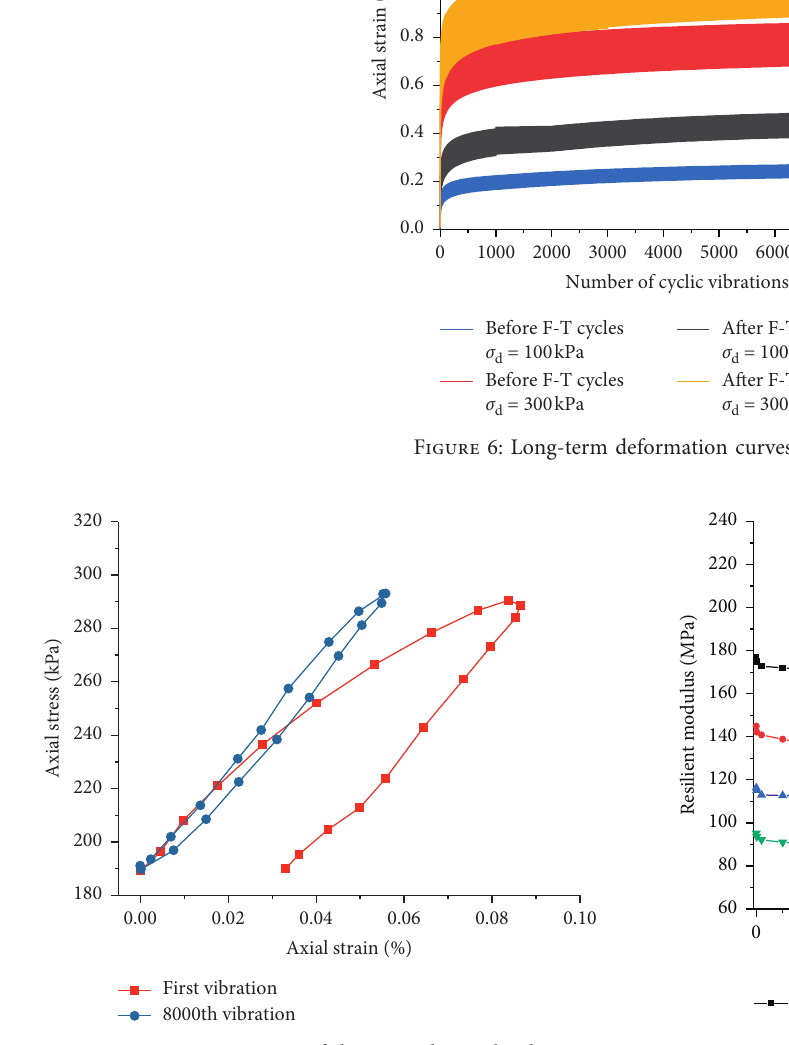
Figure 7: Stress-strain rings of the 1st and 8000th vibration.